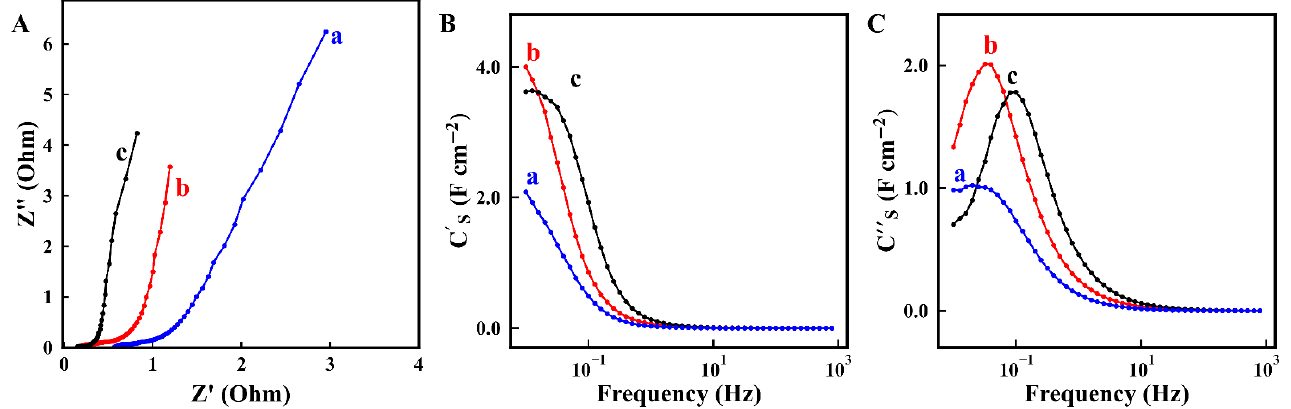
Figure 6. ( A ) Nyquist plot of impedance and ( B , C ) components complex capacitance C* = C ′ − i C ″ versus frequency for electrodes prepared (a) without dispersant, (b) in the presence of chlorogenic acid and (c) in the presence of 3,4,5-trihydroxybenzamide.